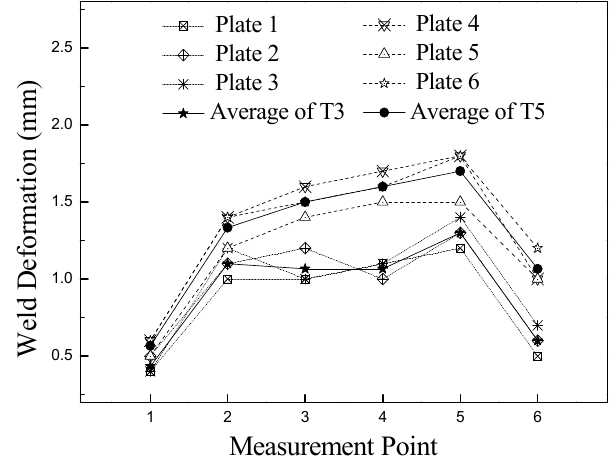
Figure 3. The experimental deformation results of welding process.